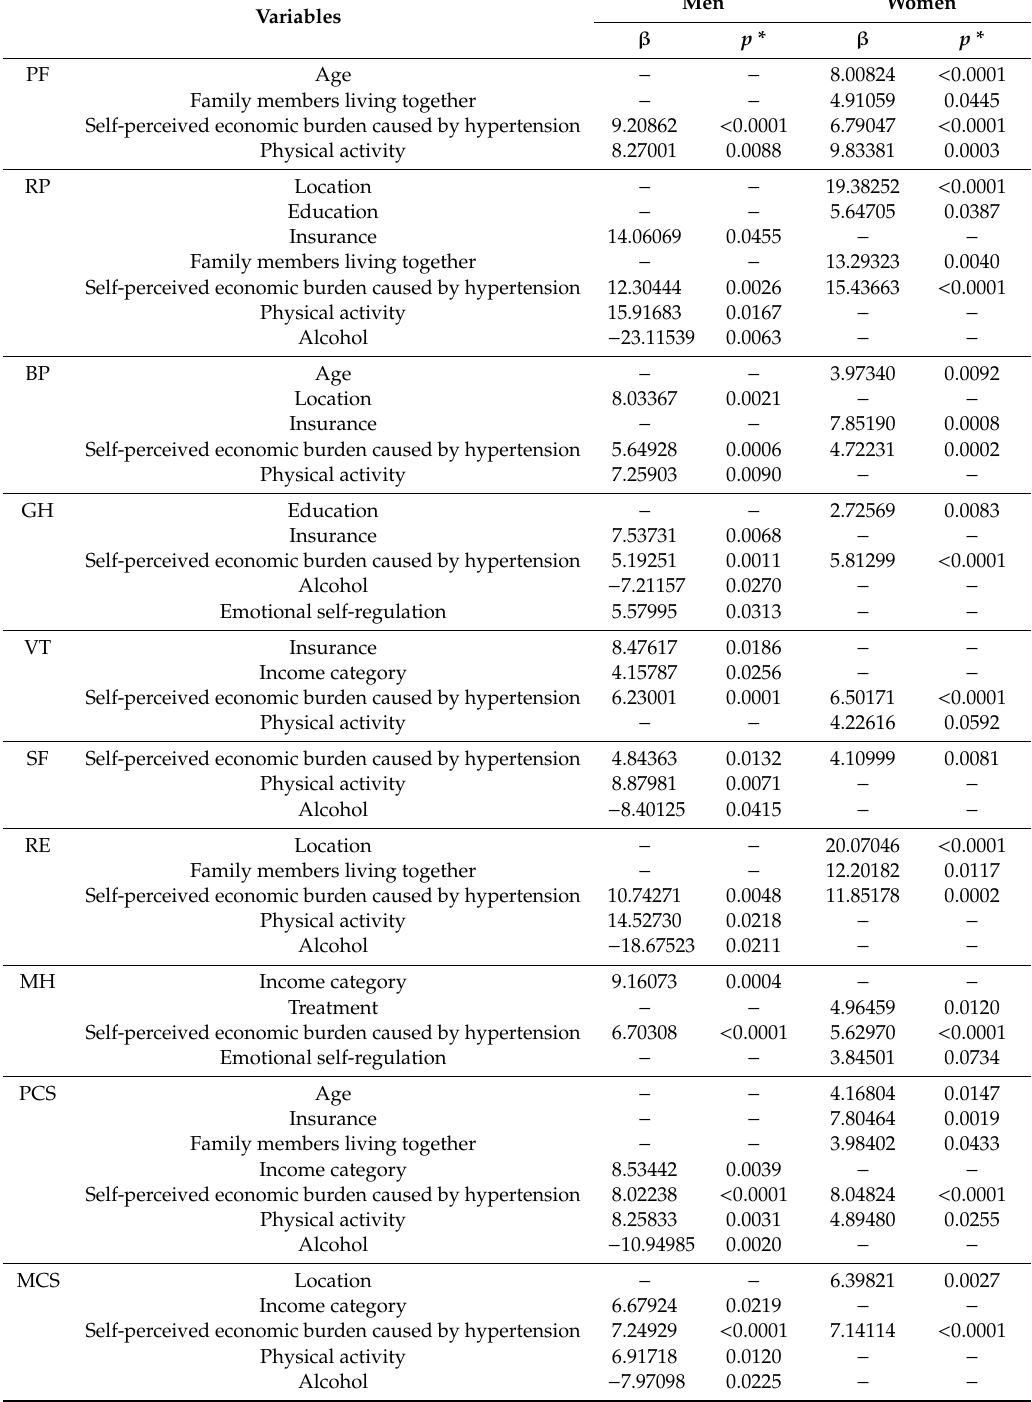
Table 3. Factors associated with the SF-36 scores stratified by sex, multiple liner